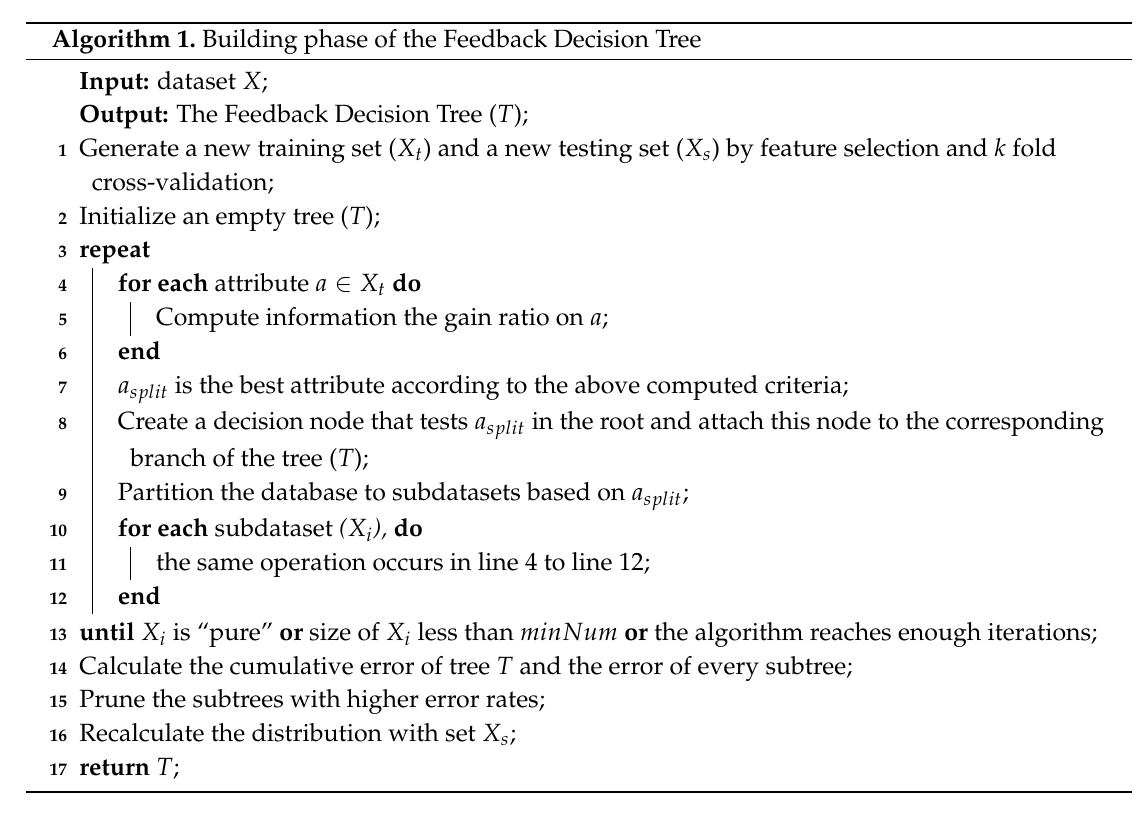
Algorithm 1. Building phase of the Feedback Decision